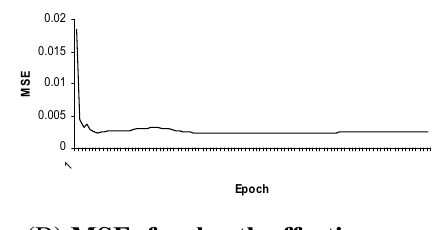
Fig. 4. The ANN model’s MSE results during testing